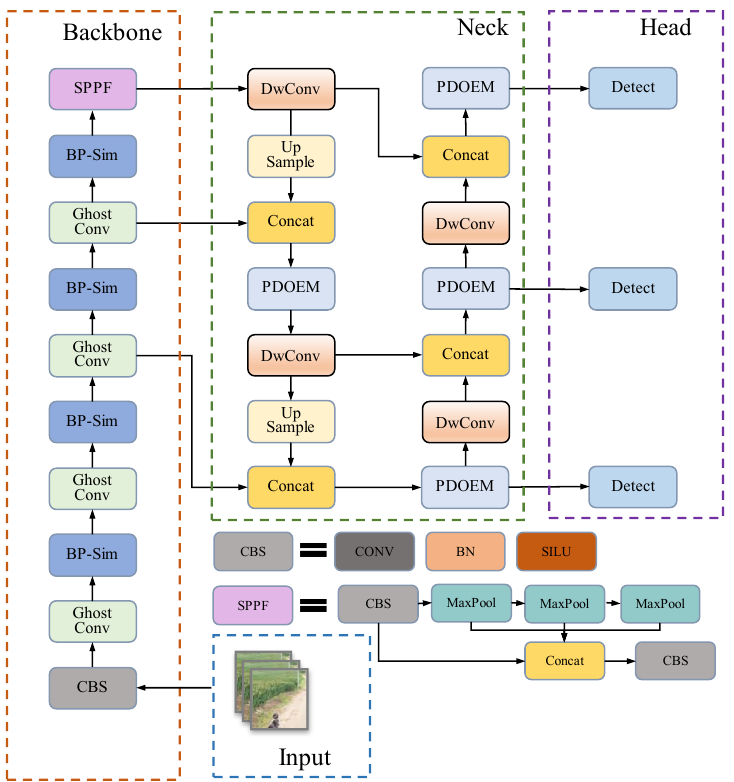
Figure 1. TP-ODA border patrol object detection network architecture.